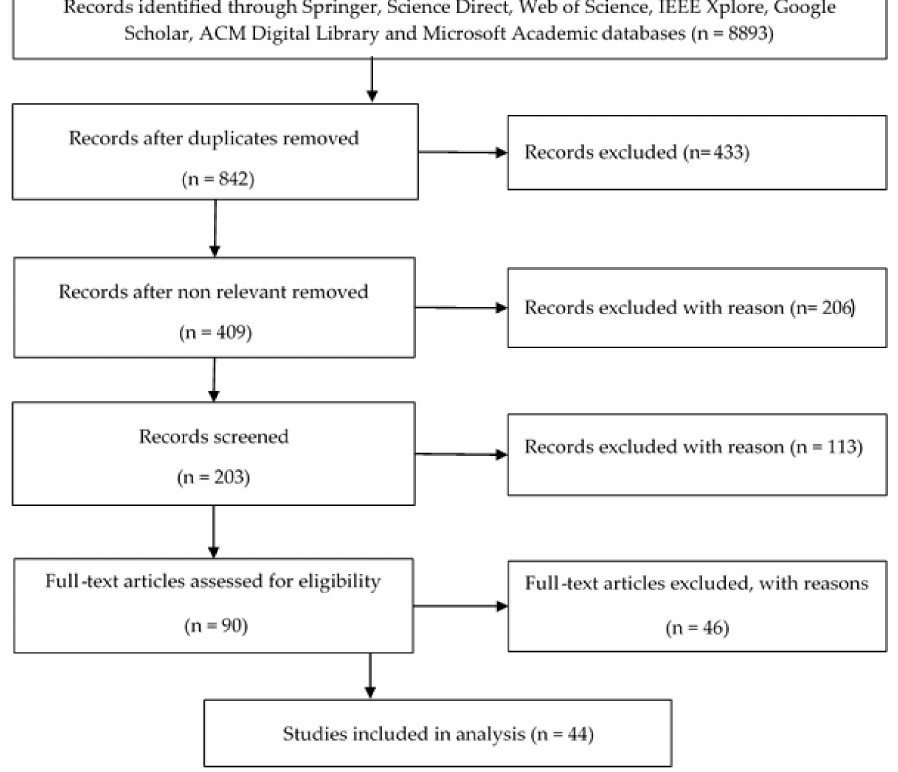
Figure 1. PRISMA flowchart